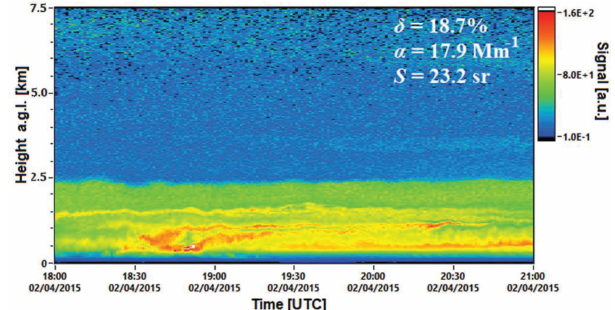
Figure 11. 1064nm range-corrected signal (in arbitrary units) ob- served with lidar at Dushanbe, Tajikistan, on 2 April 2015, 18:00– 21:00UTC (23:00–02:00 local time). The given numbers for the depolarization ratio δ , the particle extinction coefficient α , and the lidar ratio S are mean values for the aerosol layer from 1.6 to 2.1km height and the time period from 18:20 to 19:30UTC. The incom- plete laser-beam receiver-field-of-view overlap prohibits full signal detection up to about 500m height.